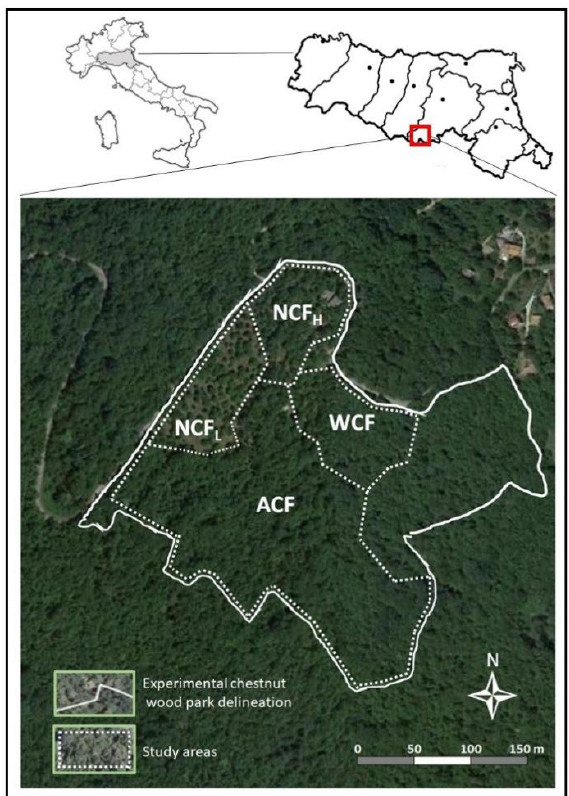
Figure 1. Location of study sites in the northern part of the Apennine chain, Italy. ACF: abandoned chestnut forest; chestnut forest for wood production (WCF); chestnut forest for nut production with a tree density of 98 plants ha − 1 (NCF L ); a chestnut forest for nut production with a tree density of 120 plants ha − 1 (NCF H ).